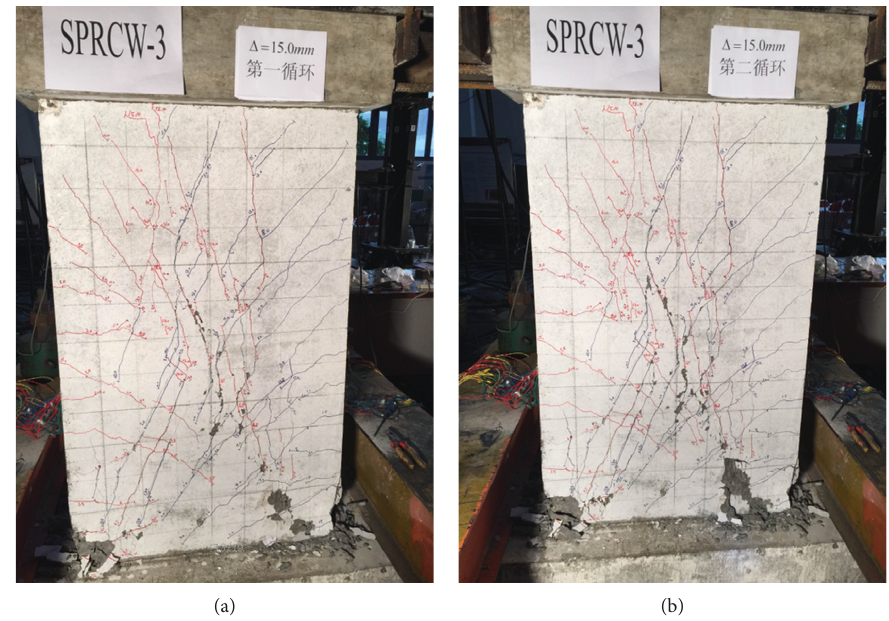
Figure 17: Diagram of cracks in the Δ � 15mm displacement cycle. (a) First cycle. (b) Second cycle.